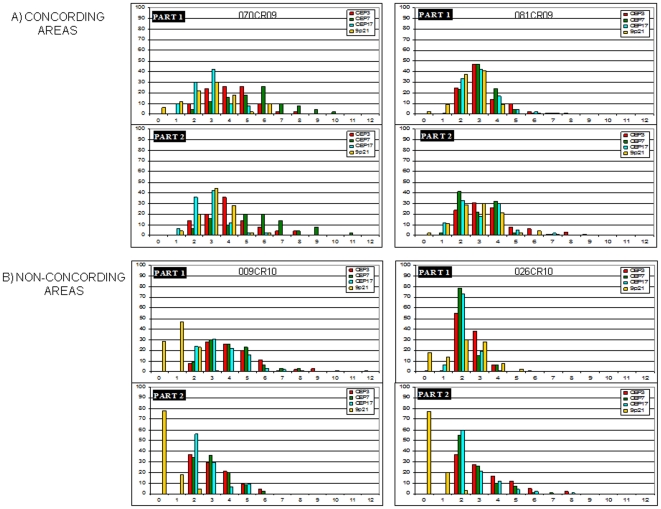
Examples of concordant and non-concordant results of Urovysion test.Comparison between results on two selected tumoral areas of the same section of FFPE: (A): the two most concordant tumors (070CR09 and 081CR09); (B): the two most discordant tumors (009CR10 and 026CR10).